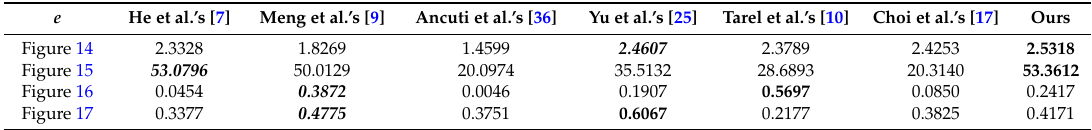
Table 3. Comparison of e for the dehazing results obtained via different methods.